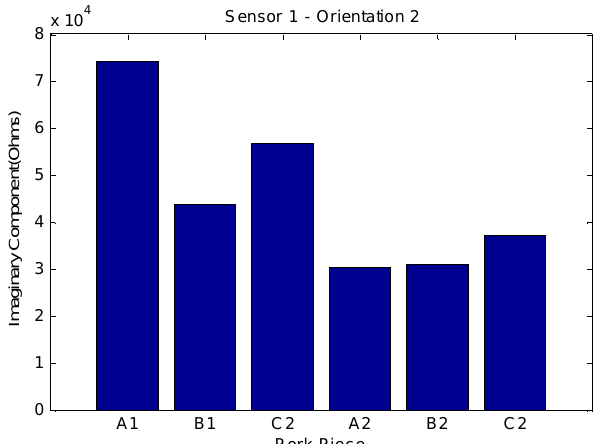
Figure 41. Sensor 1 characteristics at 5 kHz for pork belly samples at orientation 2.